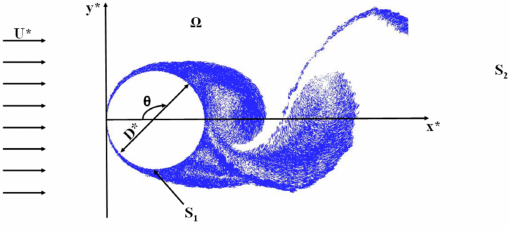
Figure 1. Definition of the fluid domain for the investigated problem, Ω